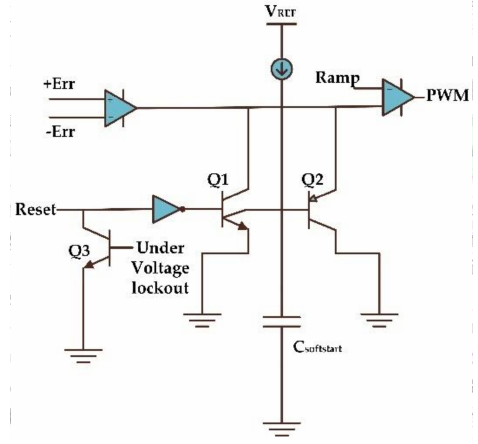
Figure 2. Soft-start circuit in IC